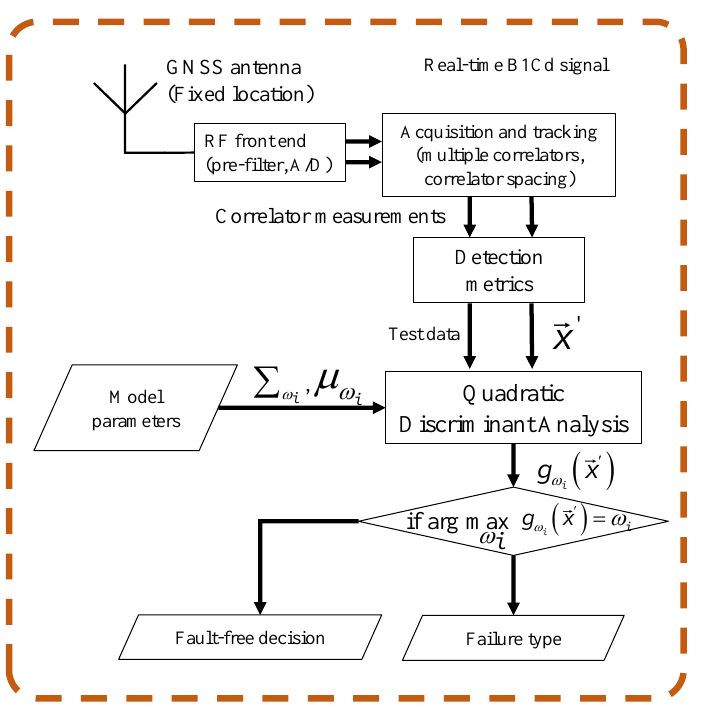
Figure 3. Flow chart of online monitoring based on QDA.